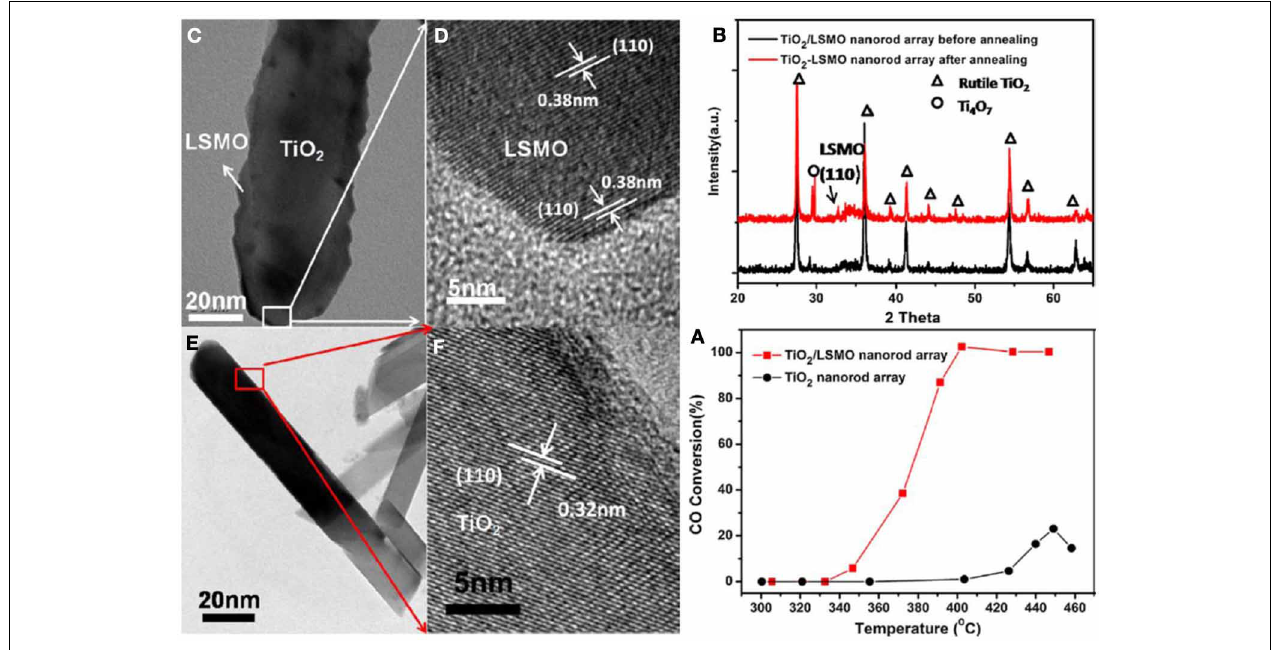
FIGURE 9 | Rutile TiO 2 /LSMO nanorod arrays for CO oxidation. (A) Catalytic CO oxidation performance of two dimensional TiO2/LSMO composite nanowires array. (B) X-ray diffraction pattern of the nanowires array before and after thermal annealing. (C,D)